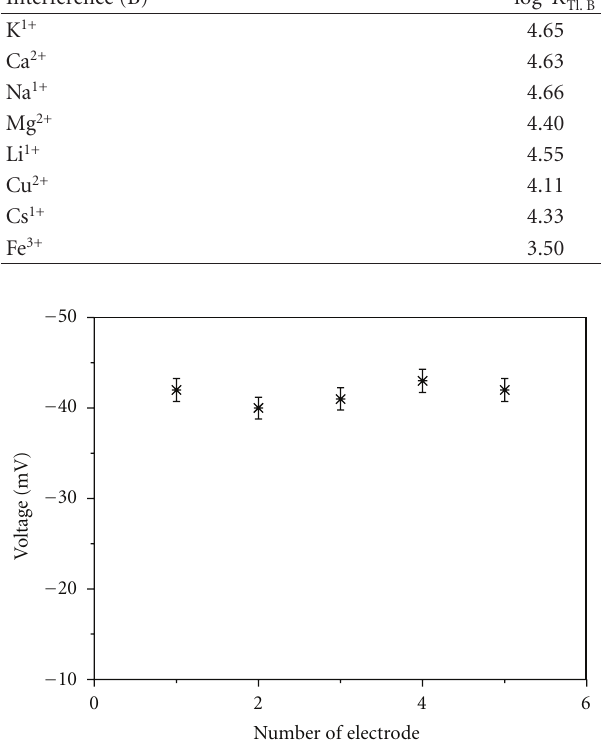
Figure 6: The sensor to sensor response in the 1 × 10 − 5 M. Table 2: Representing the durability of thallium (I) ion sensor. Number of days Slope (mV/decade)